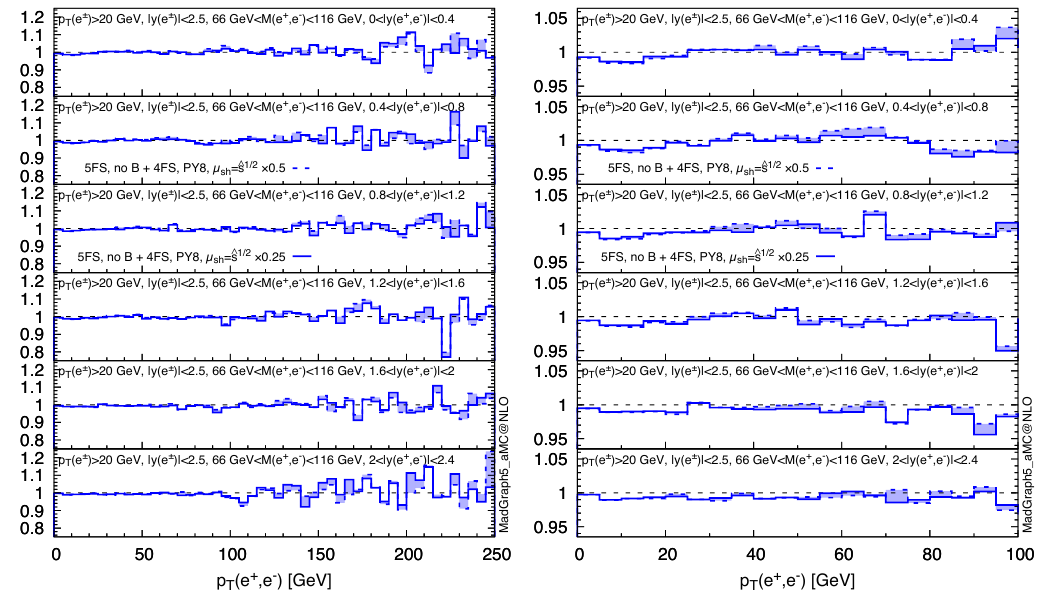
Figure 12 . Ratio of the p ‘ + ‘ (cid:0) distribution in the re(cid:12)ned approximation including the bottom- ? quark mass e(cid:11)ects over the plain 5FS, in di(cid:11)erent bins of the lepton-pair rapidity. The plot on the left is a zoom on the low- p ‘ + ‘ (cid:0) region of the plot on the right. ?